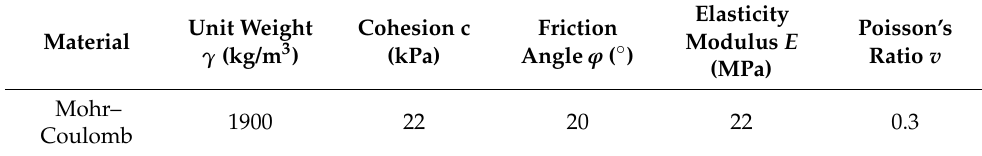
Table 1. The parameters of plates.